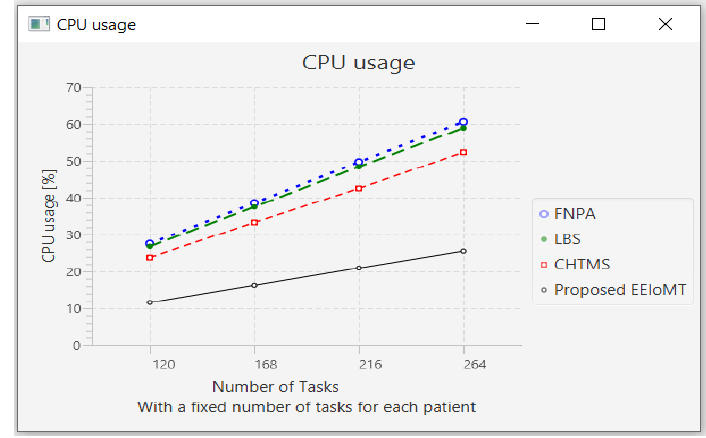
Figure 23. CPU usage comparison when changing the number of tasks.